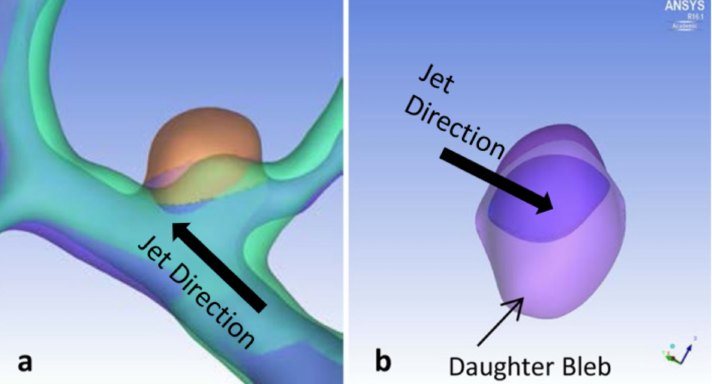
Figure 8. P4 aneurysm growth comparisons between initial diagnosis and follow-up times. ( a ) Top view and ( b ) side view, with block arrows indicating direction of impingement jet.